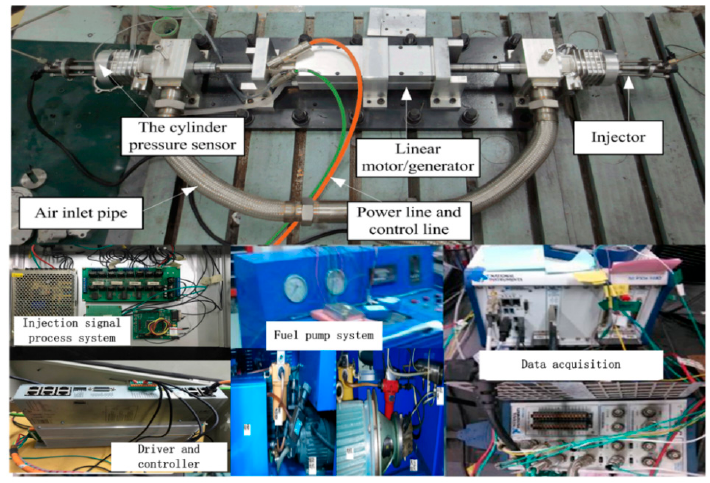
Figure 2. FPLG experiment rig.